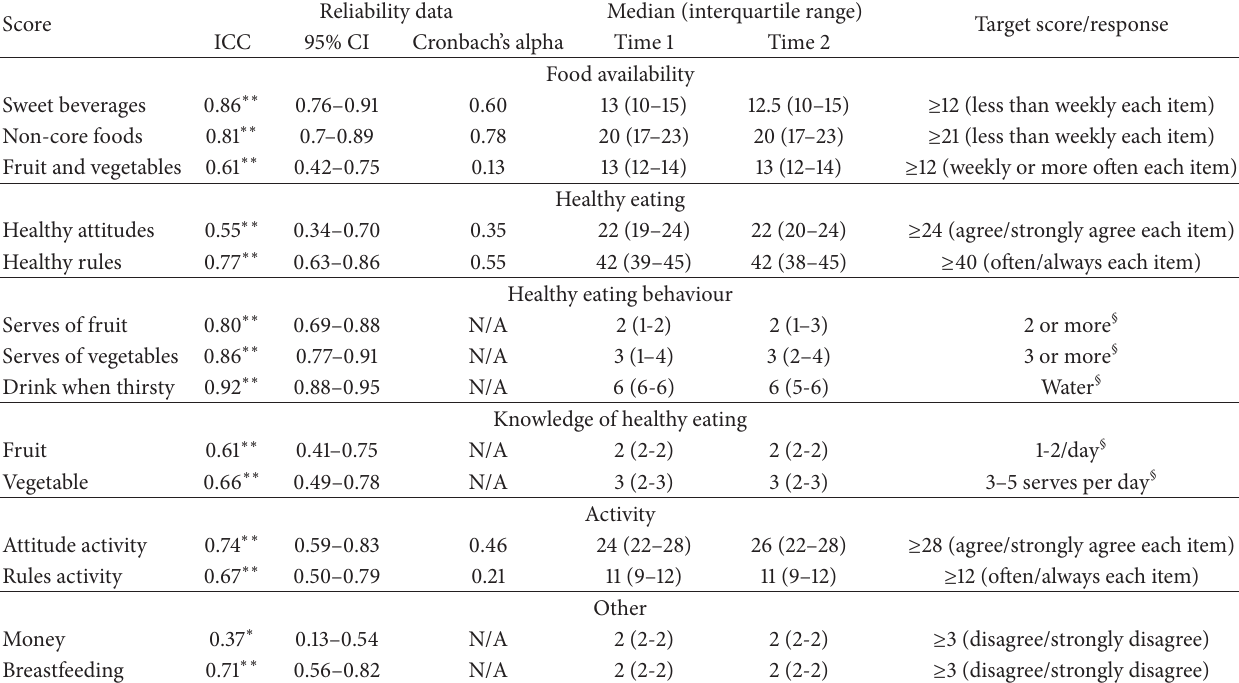
Table 3: Reliability ( 𝑛 = 60 † ) demonstrated by intraclass correlation coefficient (ICC) and 95% confidence intervals (CI) for the parent outcomes and internal consistency for the parent scores.